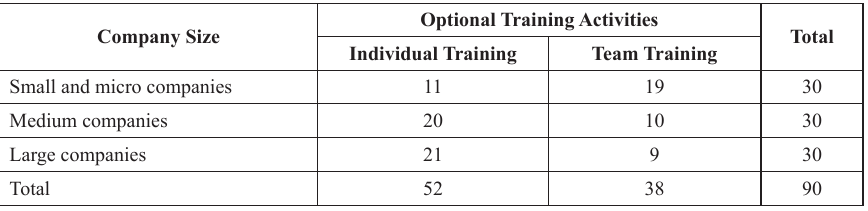
Table 3. Character of optional on-the-job training according to the employer’s approach Company